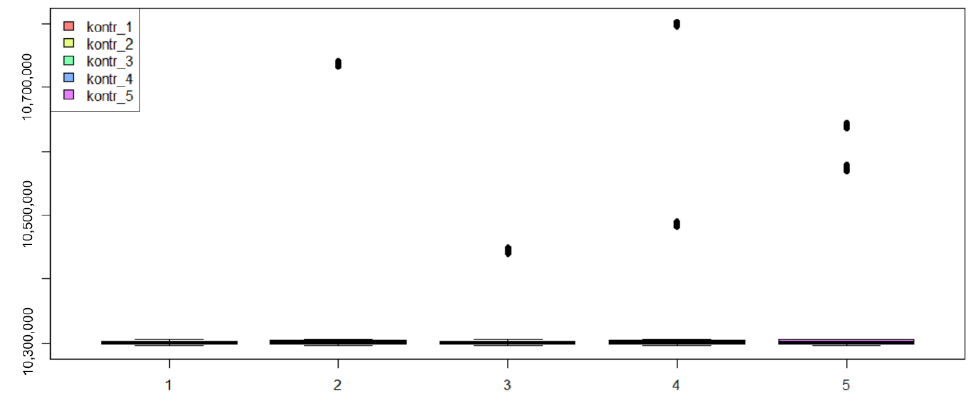
Figure 12. Pressure by contractor.